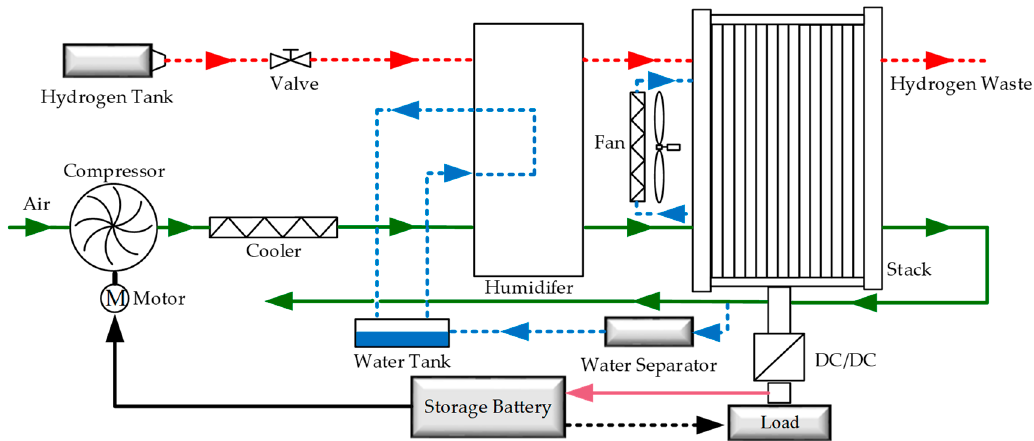
Figure 1. Distribution diagram of proton exchange membrane fuel cell (PEMFC) system architecture.